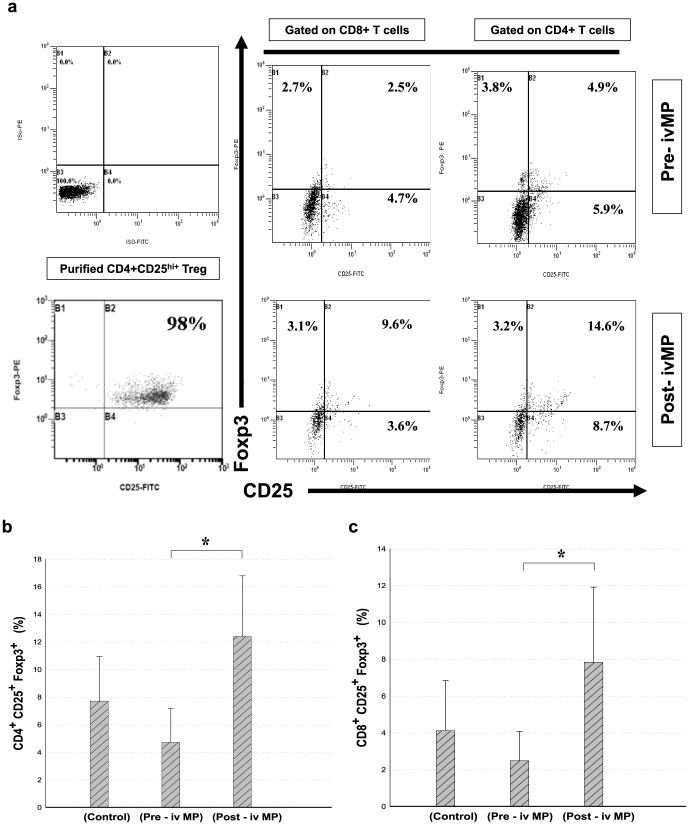
CD4+CD25+FoxP3+ and CD8+CD25+FoxP3+ Treg cells before and after IVMP pulse therapy.(a) PBMCs from LN patients during IVMP pulse therapy were stimulated with anti-CD3 mAb stimulation (5 ug/ml) and IL-2 (10 U/ml) for five days, and cells with intracellular expression of FoxP3 were analyzed for CD4+CD25+ and CD8+CD25+ T cells, representative figures shown. Analysis of CD4+CD25+FoxP3 Treg cells (b) and CD8+CD25+FoxP3 Treg cells (c) in PBMCs before and after IVMP pulse therapy by flow cytometry. Bars represent mean ± SD.